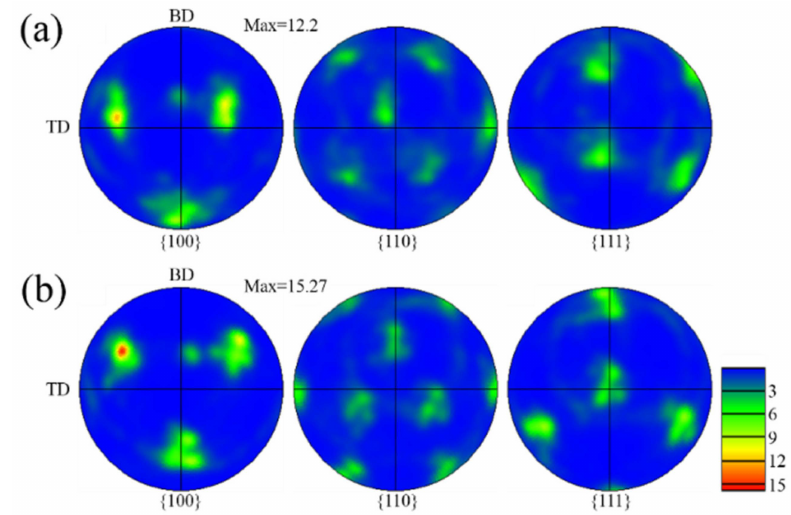
Figure 4. Pole figure with different z-increment: ( a ) 0.2 mm; ( b ) 0.4